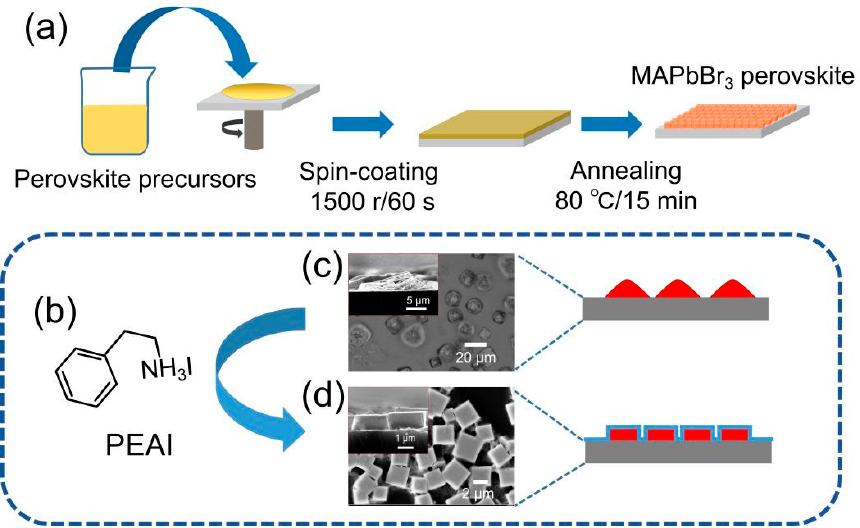
Figure 1. ( a ) Schematic illustration of perovskite film preparation. ( b ) The chemical structure of phenethylammonium iodide (PEAI). ( c ) SEM images of perovskite without PEAI. ( d ) SEM images of perovskite with PEAI (0.15